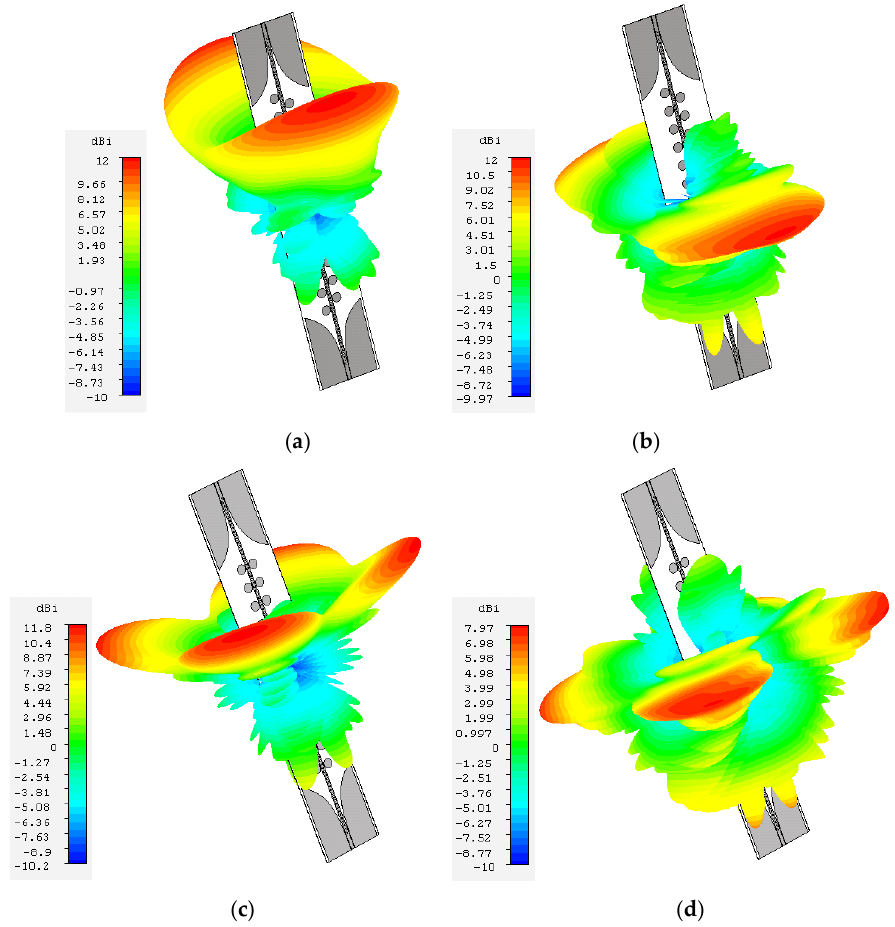
Figure 9. The simulated 3D far-field radiation patterns of the SSPP LWA. ( a ) delta = 10 mm @8 GHz; ( b ) delta = 10 mm @12 GHz; ( c ) delta = 0 mm @8 GHz; ( d ) delta = 0 mm @12 GHz.